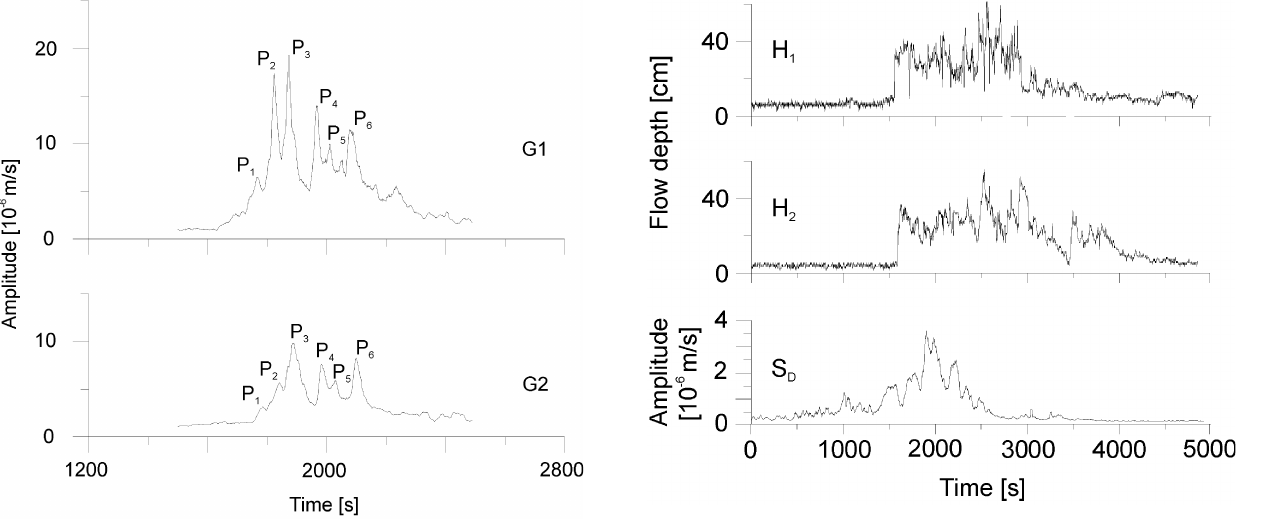
Fig. 4. The two graphs recorded at the geophones G1 and G2 at the upstream seismic network resemble each other and show cor- responding peaks that are separated by similar time intervals (Ta- ble 2), which are consistent with the value obtained through cross- correlation.